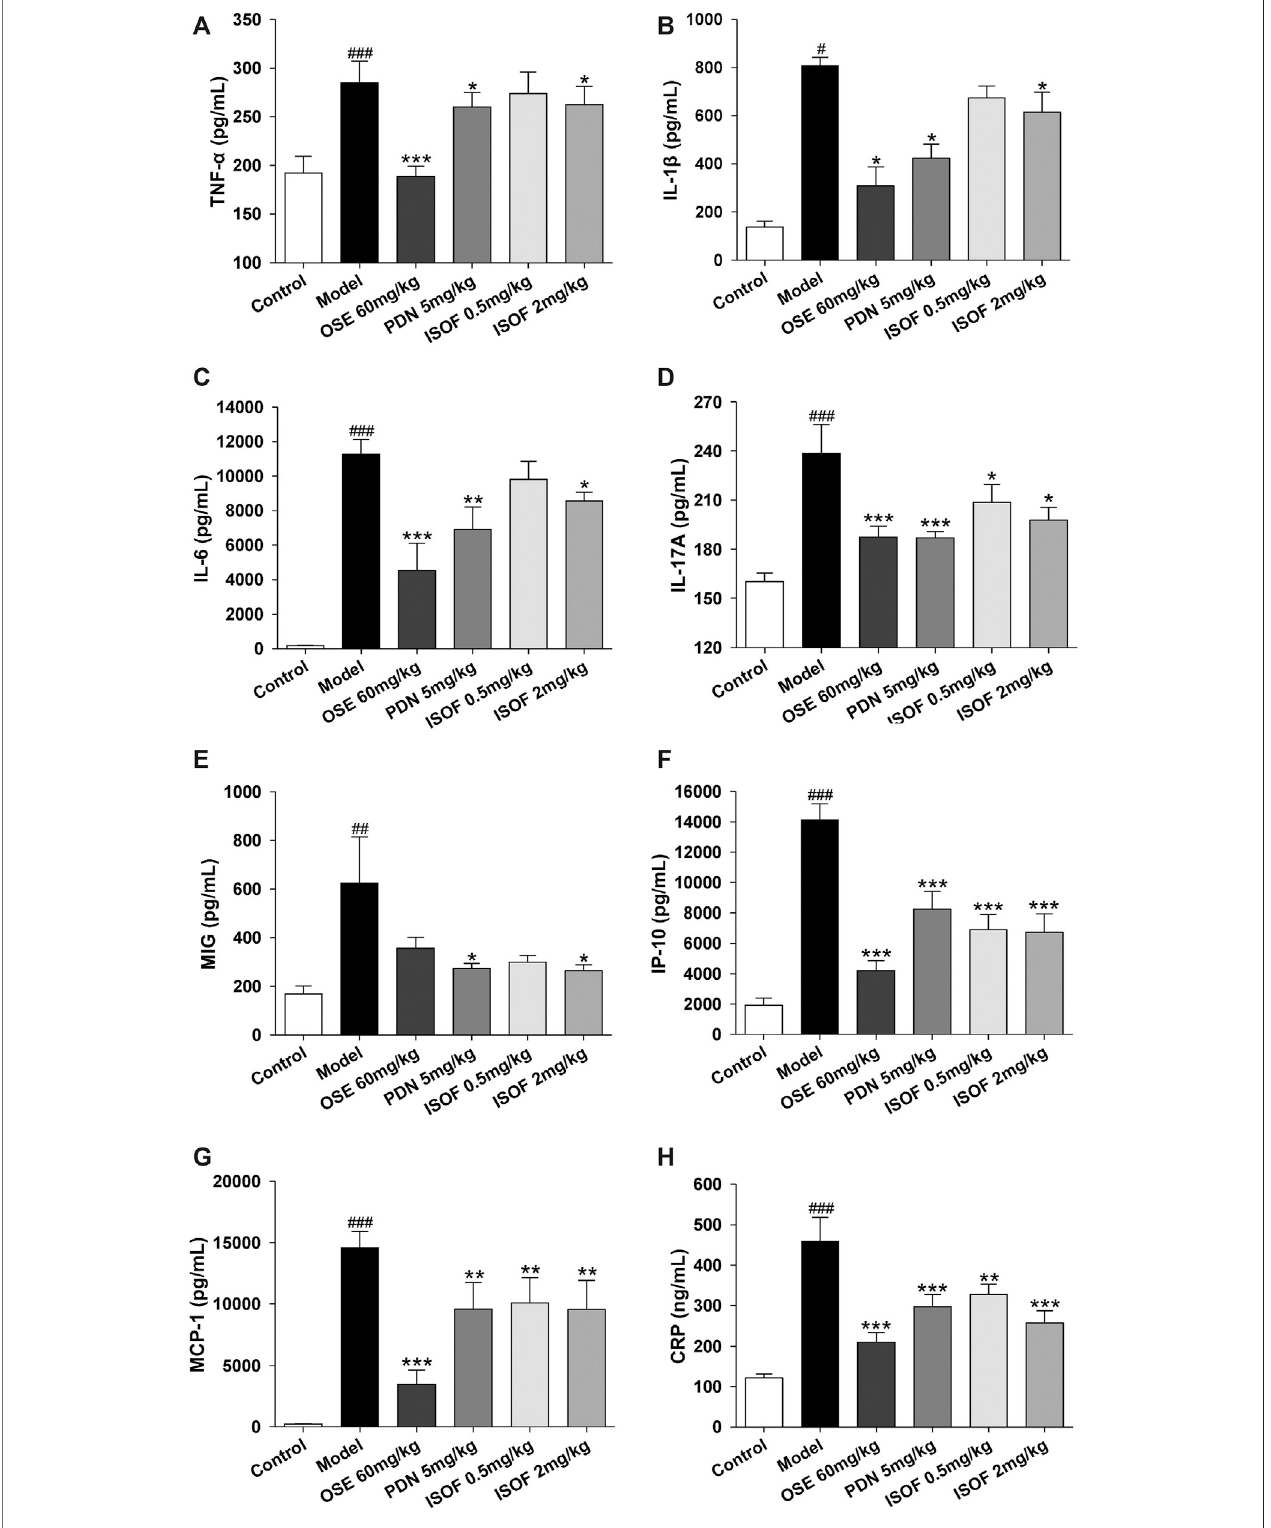
FIGURE 5 | ISOF decreased proin fl ammatory cytokines in the lung homogenate of AECOPD model mice. The levels of TNF- α (A) , IL-1 β (B) , IL-6 (C) , IL-17A (D) , MCP-1 (E) ,MIG (F) ,IP-10 (G), andCRP (H) ineachgroupweremeasuredbytheBio-PlexProMouseCytokineassayorELISA.Dataareexpressedasmeans ± SEM( n (cid:1) 6 in each group). # p < 0.05, ## p < 0.01, and ### p < 0.001 vs. control group; * p < 0.05, ** p < 0.01, and *** p < 0.001 vs. model group.